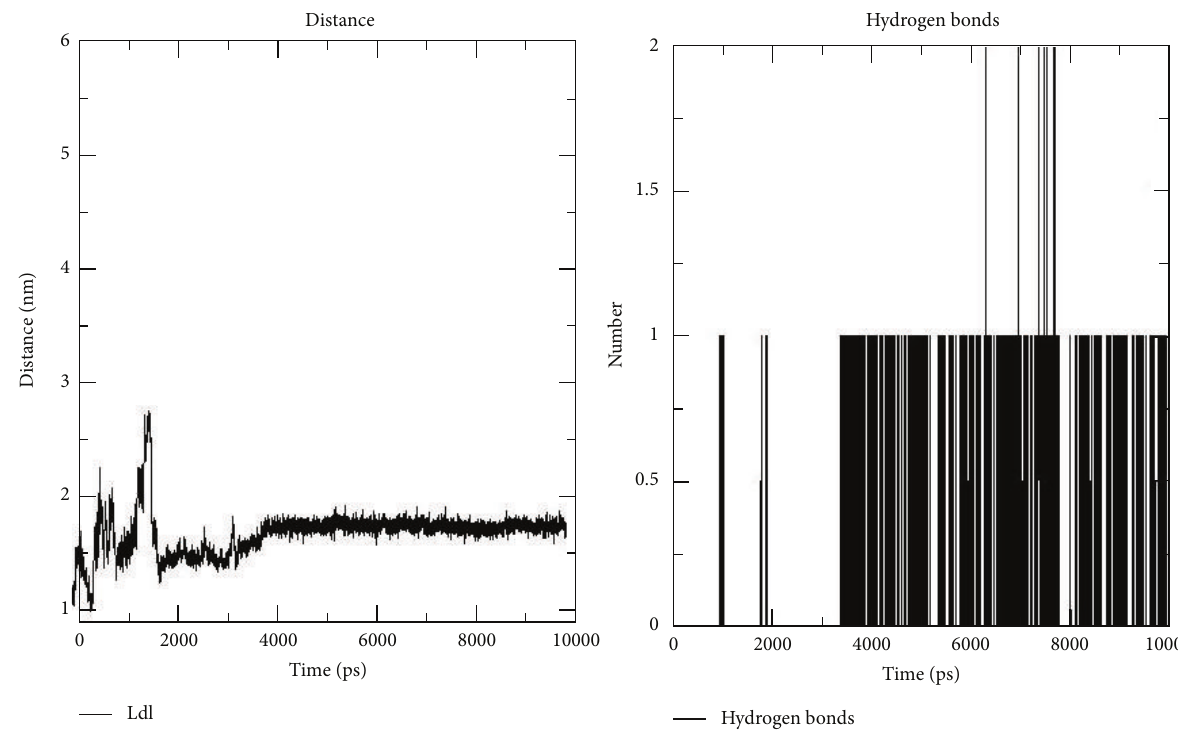
Figure 8: Distance plot of C7 from the active site residue Asp-61 through the